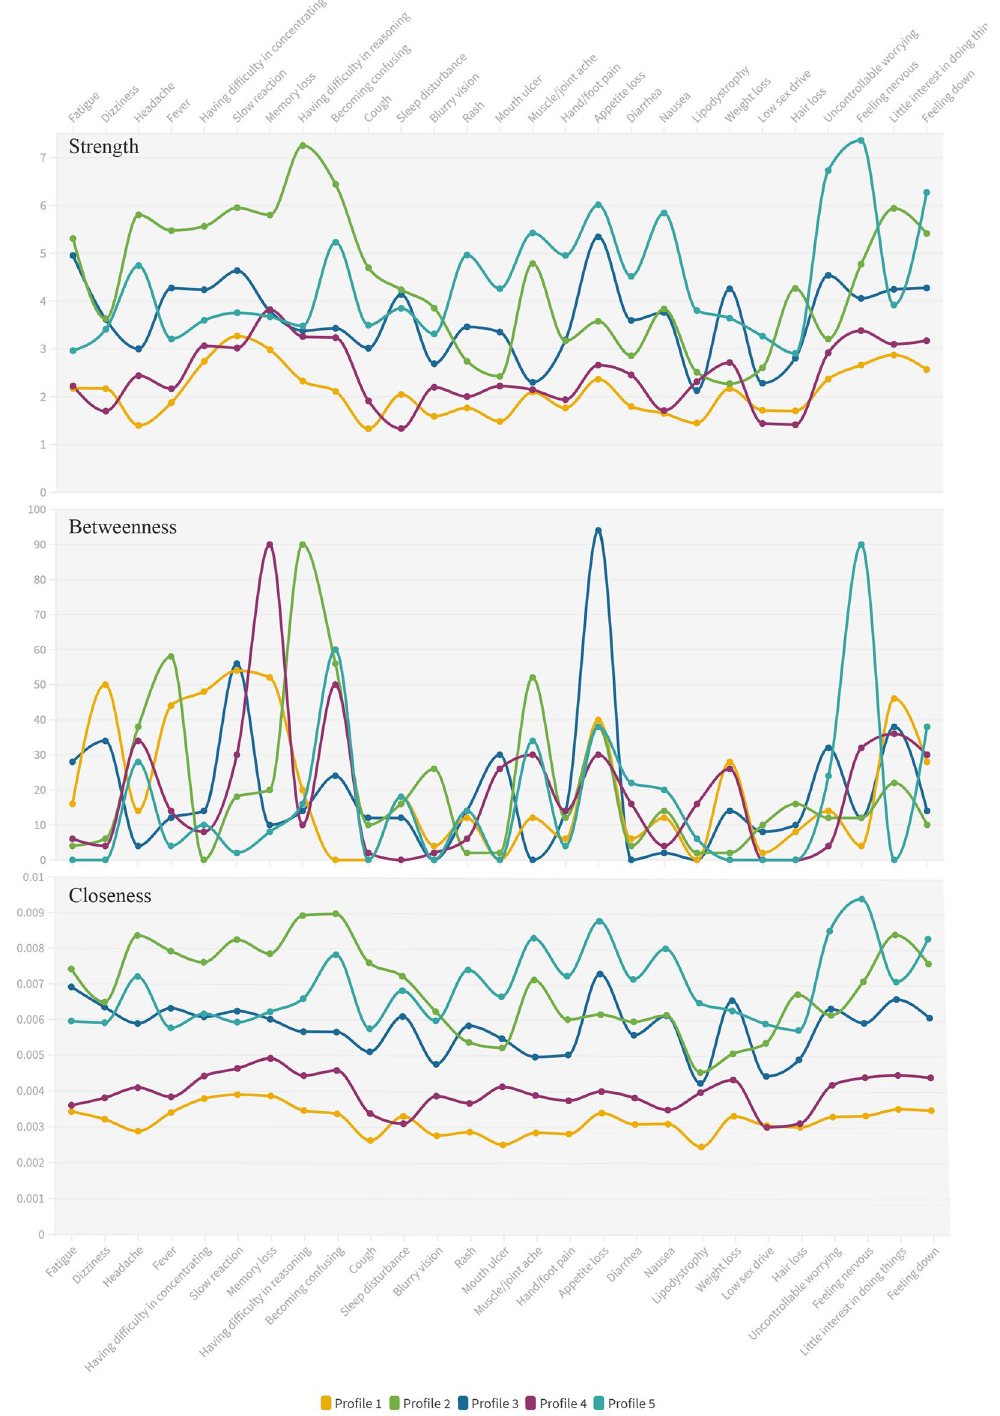
Figure 3. Centrality indices of the networks of the 5 subgroups. Strength is a measure of network connectivity. Betweenness quantifies the number of times a node acts as a bridge along the shortest path between two nodes. Closeness represents the average farness (inverse distance) from one symptom to all other nodes. For a contemporaneous network, strength is used as the major indicator among three